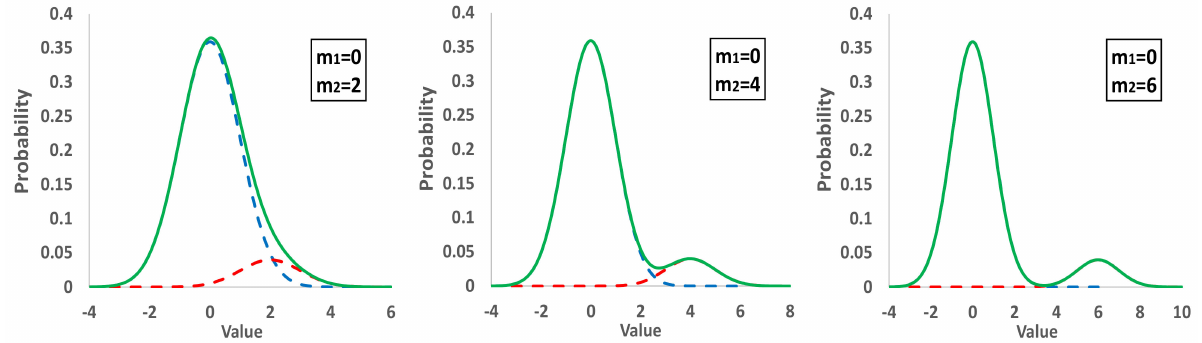
Figure 3. Distribution of populations consisting of a main and secondary distribution. Dashed lines; main and secondary groups, and solid line; total population.